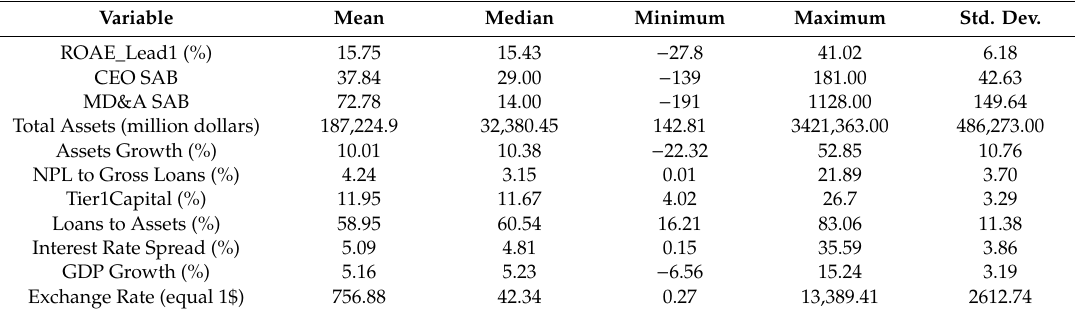
Table 2. Descriptive Statistics of SAB, Financial, and Macroeconomic